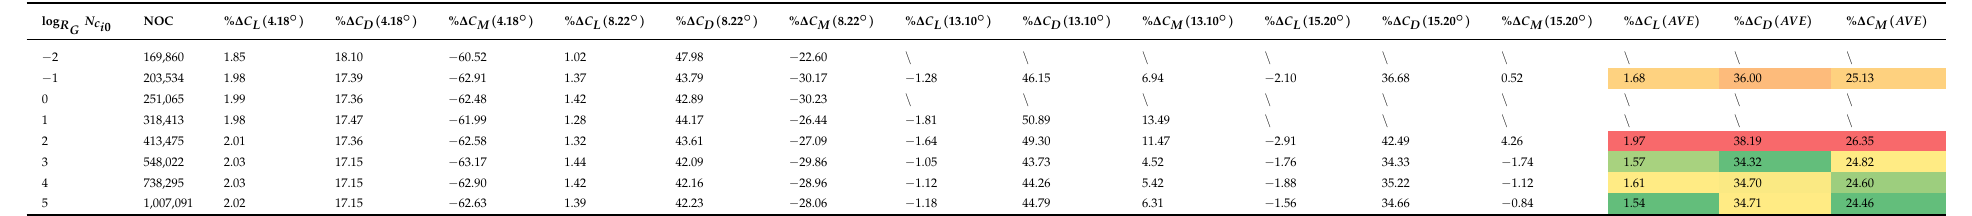
Table 7. Comparison of results of C-mesh based on various chord-wise spacings with that of experimental benchmark data adopted from [25] in relative differences with 670 nodes in chord-wise direction for reference